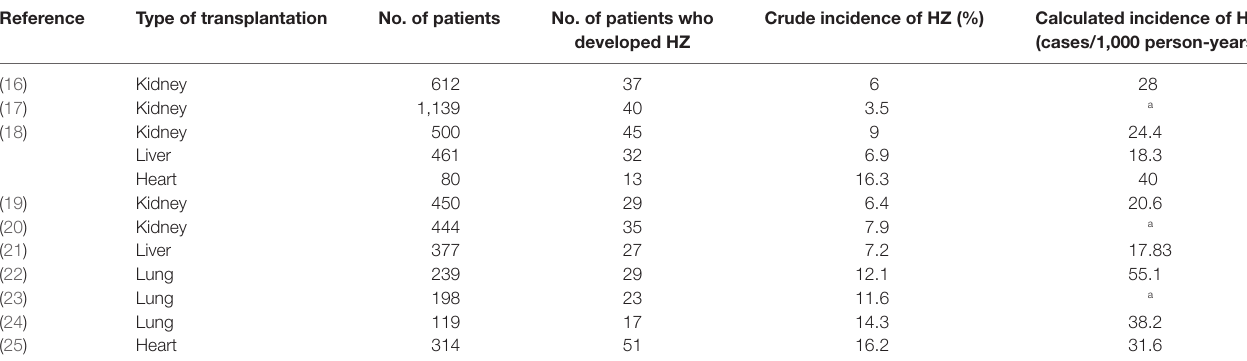
TAbLe 1 | The incidence of herpes zoster (HZ) in transplant patients.